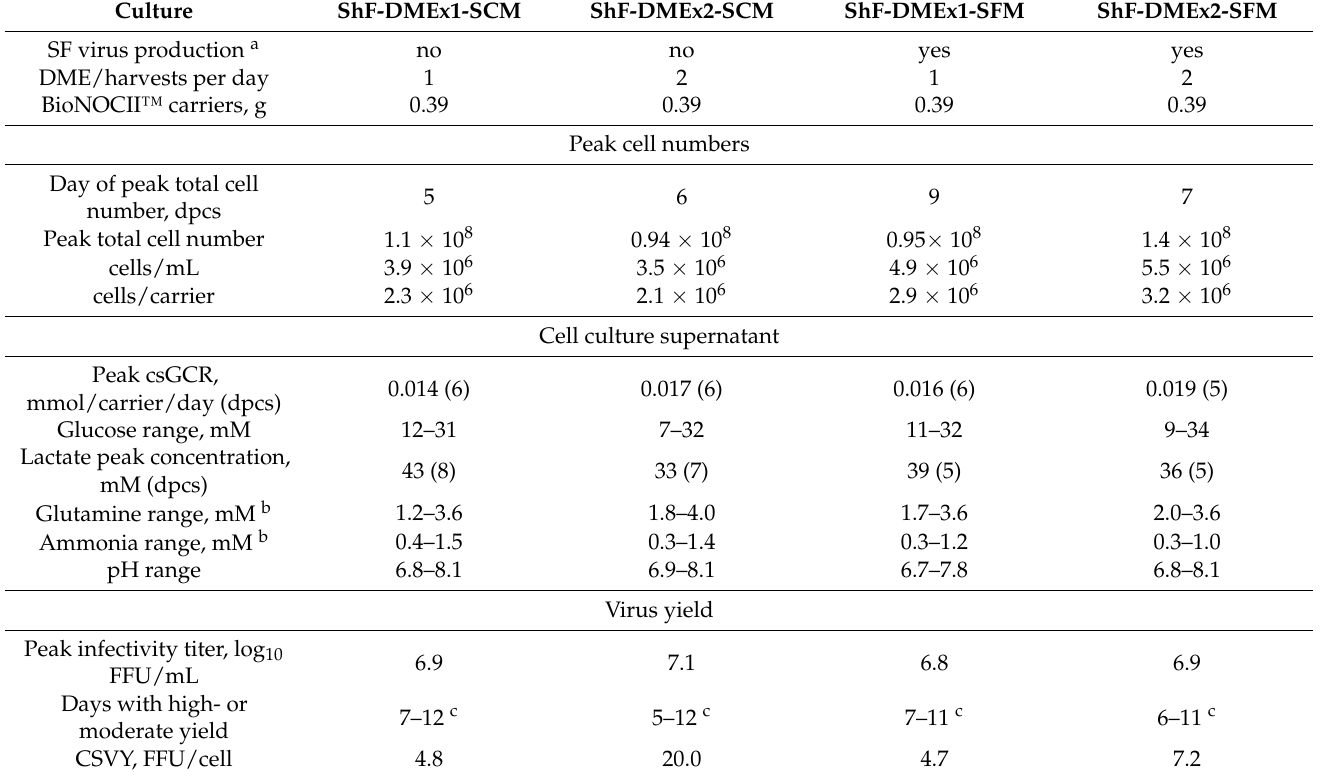
Table 2. Overview of cultivation parameters, rates, and yields of shake flask